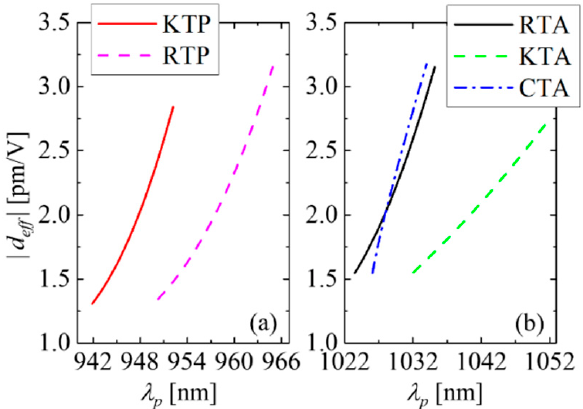
Figure 4. Effective nonlinear optic coefficients ( d eff ) calculated numerically under Type II EPM: ( a ) KTP and RTP; ( b ) RTA, KTA, and CTA. Table 3. Type II EPM conditions for the maximum effective nonlinearities: the resonant pump wavelength ( λ p ), the k -direction (i.e., θ and ϕ ), the effective nonlinear optic coefficient ( d eff ), the walk-off angle ( w ), and the beam deviation ( ∆ ).